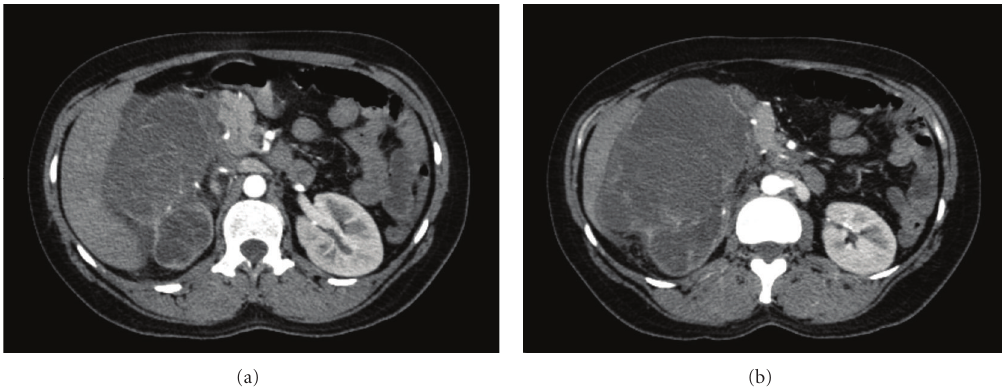
Figure 1: Cross-sectional computed tomography (CT) images showing a large heterogeneous mass replacing the right